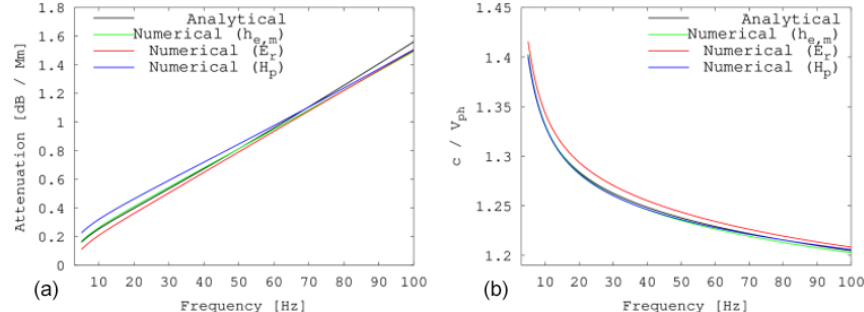
Figure 5. The attenuation rate and phase velocity that was calculated analytically and numerically. Using numerical FDTD calculations those parameters were obtained by two approaches: (a) using electric and magnetic altitudes from FDTD by Eqs. (9) and (10); and (b) directly from the spectra of electric and magnetic field components following Eq. (15), where we used probes located at 80 and 90 ◦ .